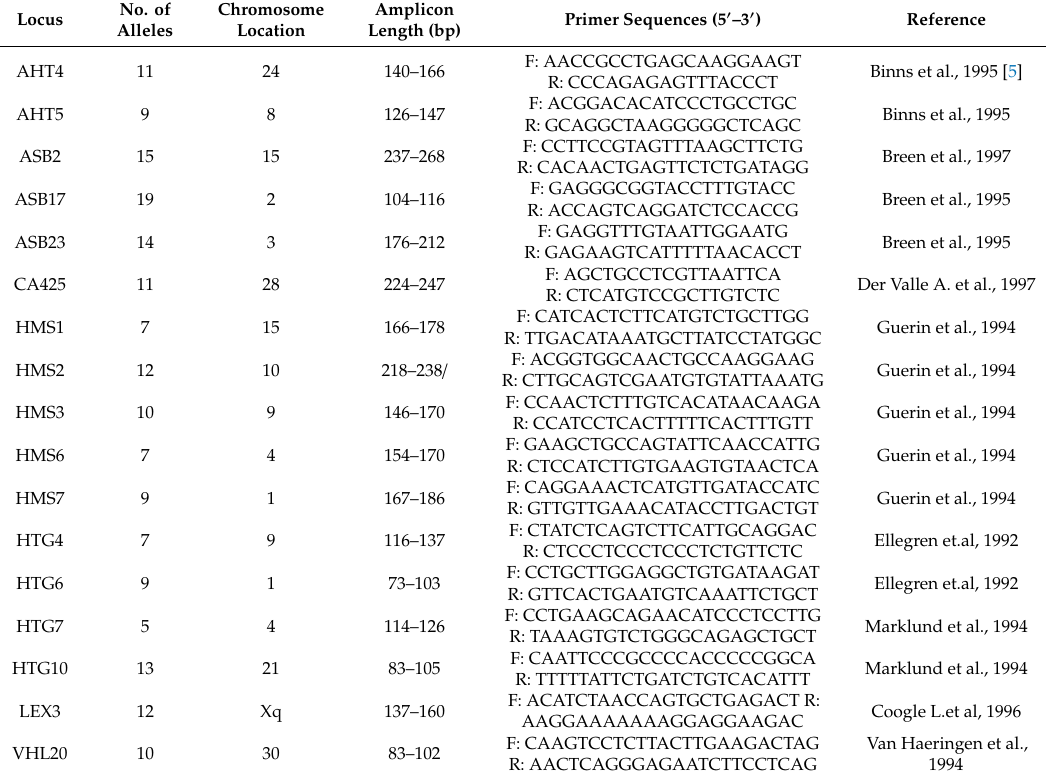
Table 1. Information for the 17 microsatellite loci used in our